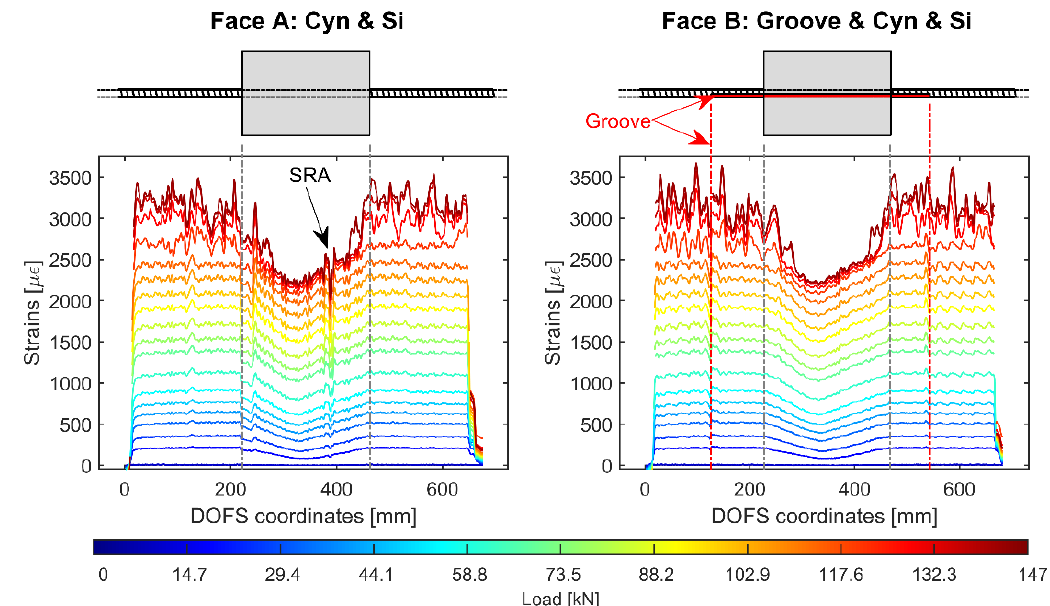
Figure 14. Strain profiles of 15D20_24_1 RC tie test with the DOFS bonded on both sides of the rebar by means of CYN and SI on one side (Face A— left ) and a groove + CYN + SI on the other (Face B— right ). Figure 15 dwells deeper in the DOFS’ signal noise, displaying its values under three load levels. A discrete noise magnitude di ff erence is noticeable according to the di ff erence of DOFS / rebar